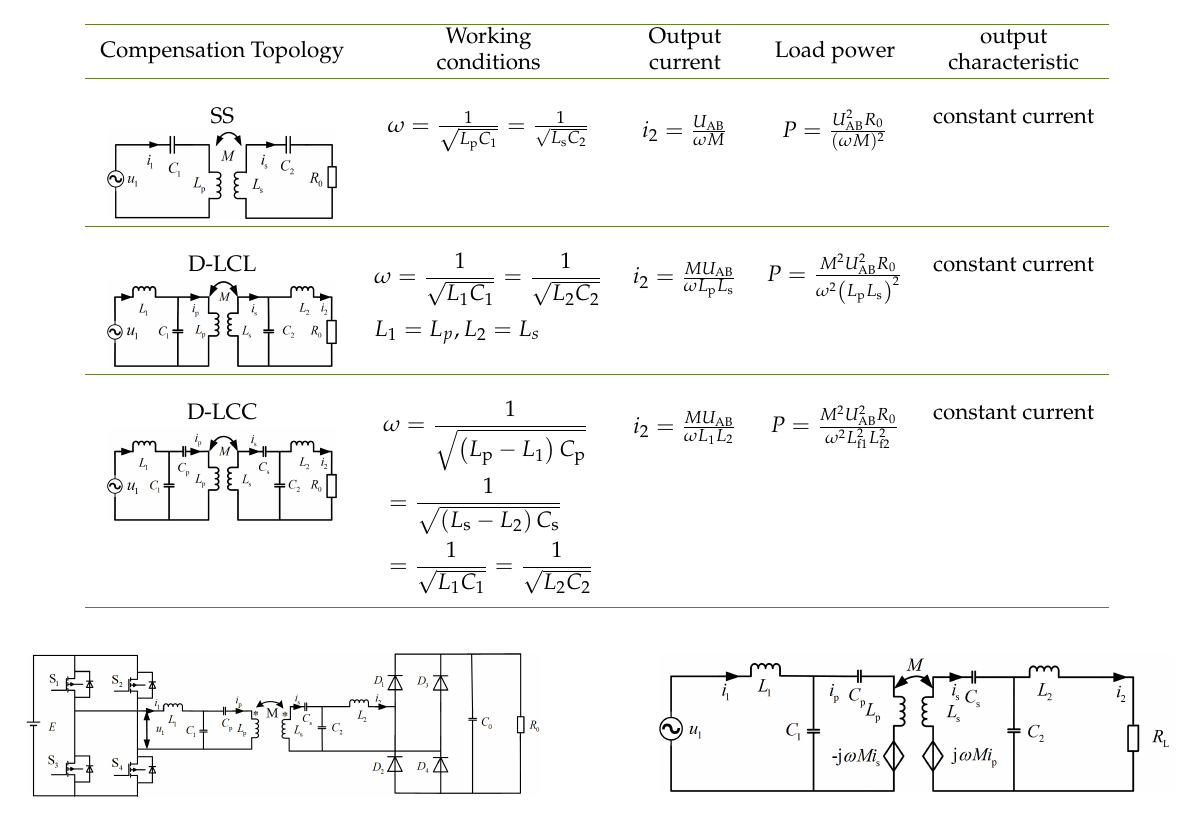
Table 2. Circuit characteristics and transmission power of SS, D-LCL and D-LCC compensation topology